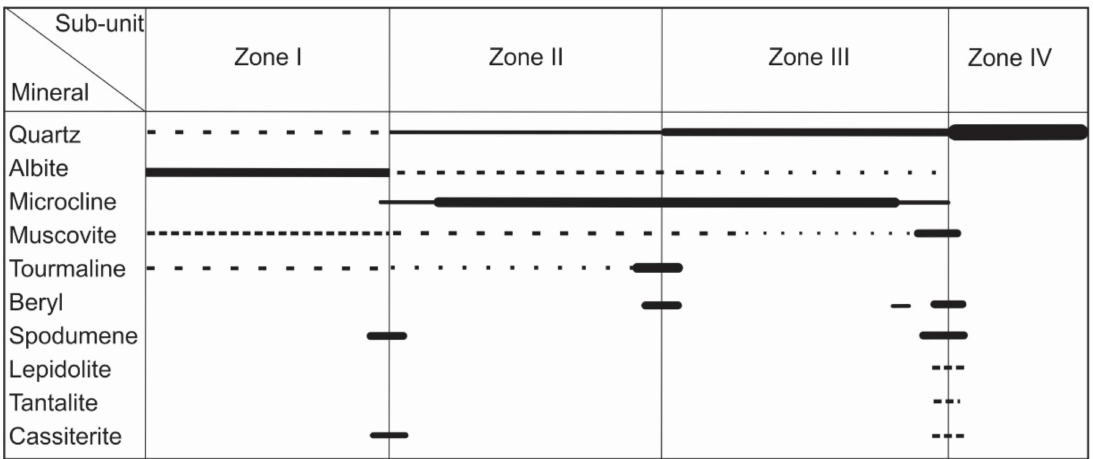
Figure 2. The paragenetic sequence of the gem-bearing Boqueir ã o granitic